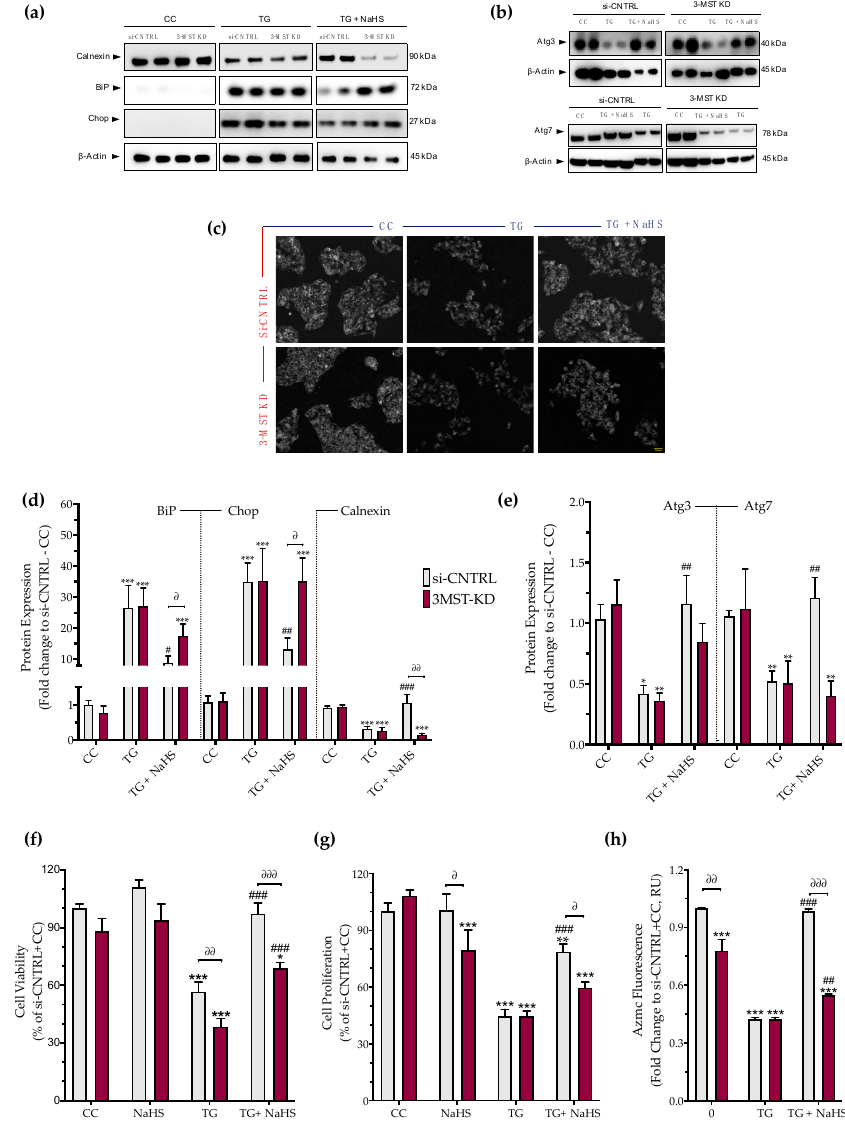
Figure 9. 3-MST silencing attenuates the restorative effects of the H 2 S donor NaHS on the ER stress response and autophagy. HepG2 cells previously subjected to 3-MST silencing (knockdown (KD)) or sham-silencing (si-CNTRL) were serum-starved for 8 h and treated with the vehicle or 100 nM of thapsigargin (TG), in the presence or absence of 100 µM NaHS for 16 h. Whole-cell lysate was collected and processed for protein expression of the UPR sensor – BiP, the UPR apoptotic mediator– Chop, the ER chaperone–calnexin ( a , d ), and of the autophagy-related proteins Atg3 and Atg7 ( b , e ). Representative images of the cells previously labeled with the Autophagosome Detection probe were captured under the Olympus CKX53 inverted fluorescent microscope with a DAPI channel. Autophagy is indicated by bright dot staining of autophagic vacuoles ( c ). Micro-cultures were assayed for XTT conversion ( f ) BrdU incorporation ( g ), and AzMC fluorochrome intensity ( h ) to assess cell viability, cell proliferation, and intracellular H 2 S levels, respectively. Each bar represents mean ± SEM from three and four independent experiments for Western blotting and cell-physiology studies, respectively. Data are expressed as a percentage of the transfection negative control, control (vehicle-treated) conditions (si-CNTRL+CC). * p ≤ 0.05, ** p ≤ 0.01 and *** p ≤ 0.001 compared to corresponding CC; # p ≤ 0.05, ## p ≤ 0.01 and ### p ≤ 0.001 compared to the corresponding TG-treated cells; ∂ p ≤ 0.05, ∂∂ p ≤ 0.01 and ∂∂∂ p ≤ 0.001 compared to the corresponding 3-MST KD treatment group.